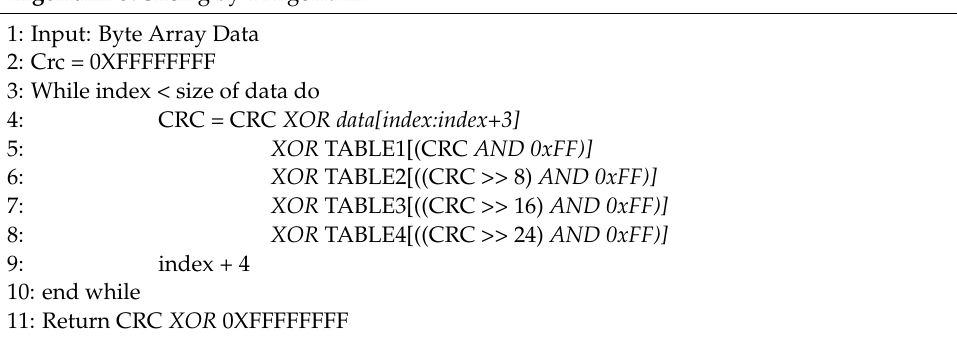
Algorithm 3. Slicing by 4